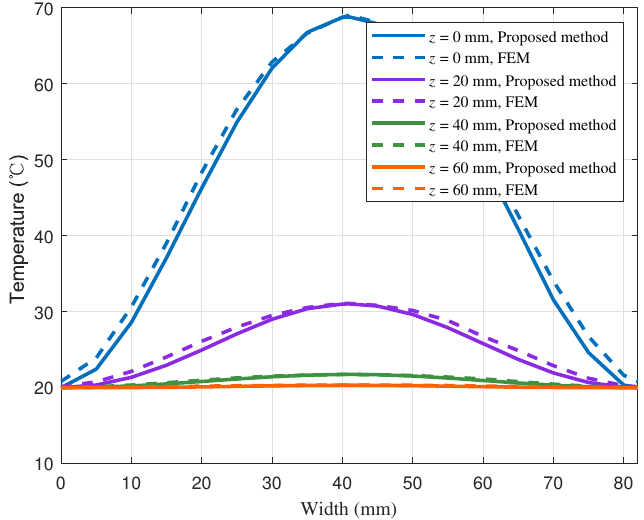
Figure 6. The temperature distribution when z is 0, 20, 40, and 60